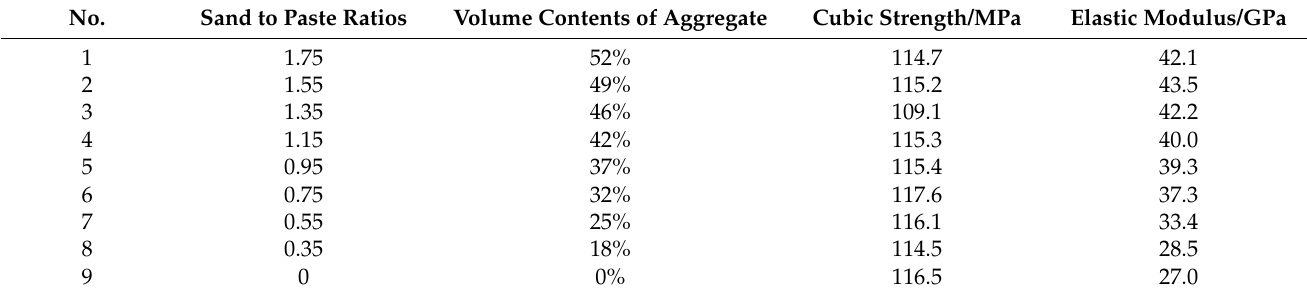
Table 6. Strength and elastic modulus of grout materials with different sand to paste